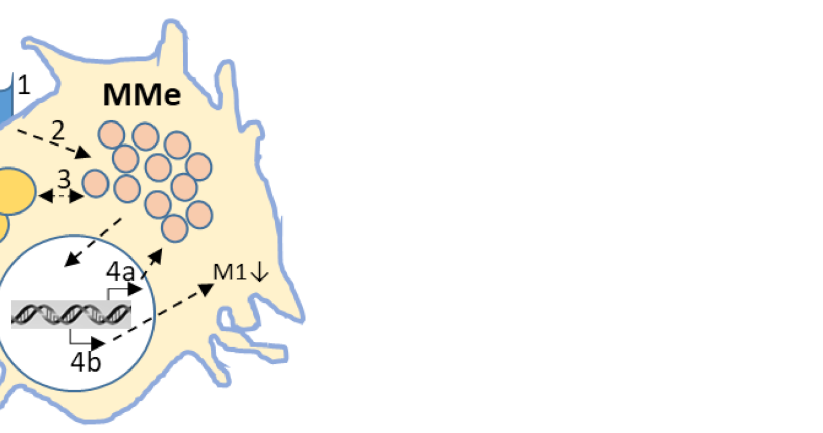
Figure 4. The lipid-laden macrophage. 1. Lipid cargo enters macrophages through uptake by scavenger receptors (CD36, TREM-2), or via phagocytosis of red blood cells, or apoptotic cells. 2. Captured lipids will be broken down in lysosomes. Due to defects in the catabolic machinery (GD, or NPC), or due to acquired overload (myelin, TG, or oxLDL) lipid material will be stored in 3. droplets/lysosome. 4. Transcriptional regulation a. MiT-TFE driven lysosomal biogenesis and autophagy and b. M1 phenotype suppression (LXR/PPAR γ ). Induction of p62, occurring as a consequence of autophagy inhibition also contributes to immune